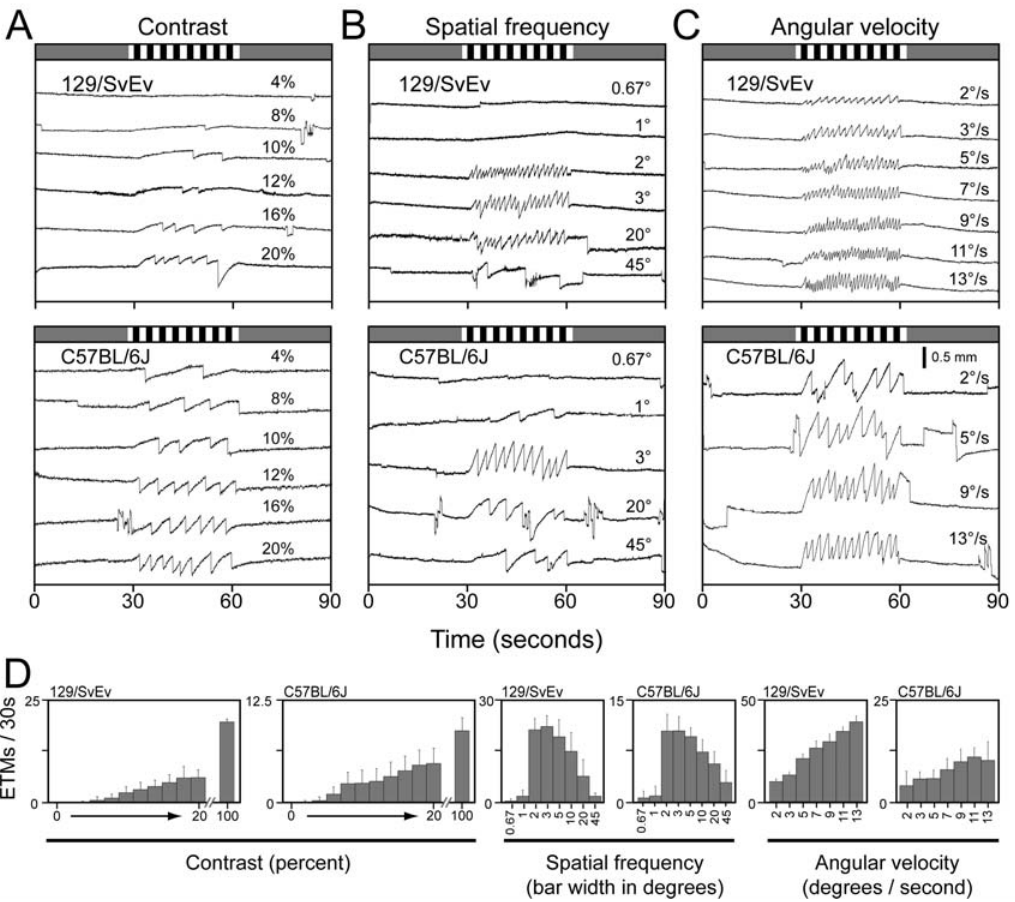
Figure 5. The sensitivity of the OKR in 129/SvEv and C57BL/6J mice to variations in contrast, spatial frequency, and angular velocity. For each of the three stimulus parameters examined, examples of OKR recordings are shown for both 129/SvEv and C57BL/6J (upper panels) and the mean + / 2 standard deviations of those responses for 4–9 mice per genotype and 11–46 30-second stimulus intervals (lower panels). Unless otherwise indicated the stimulus parameters match those shown in Figure 2. (A) Contrast sensitivity. The standard black and white striped stimulus (Figure 2; 100% contrast) was modified by producing a weighted average between the black and white stripes and a standard grey with a luminance midway between that of the black and white stripes. This operation creates stripes with contrasts ranging from 0% to 100% without changing the average luminance of the stimulus. (B) Spatial frequency. The width of each black and white stripe varied from 0.67 u to 45 u . (C) Angular velocity. The angular velocity of the standard stimulus varied from 2 u per second to 13 u per